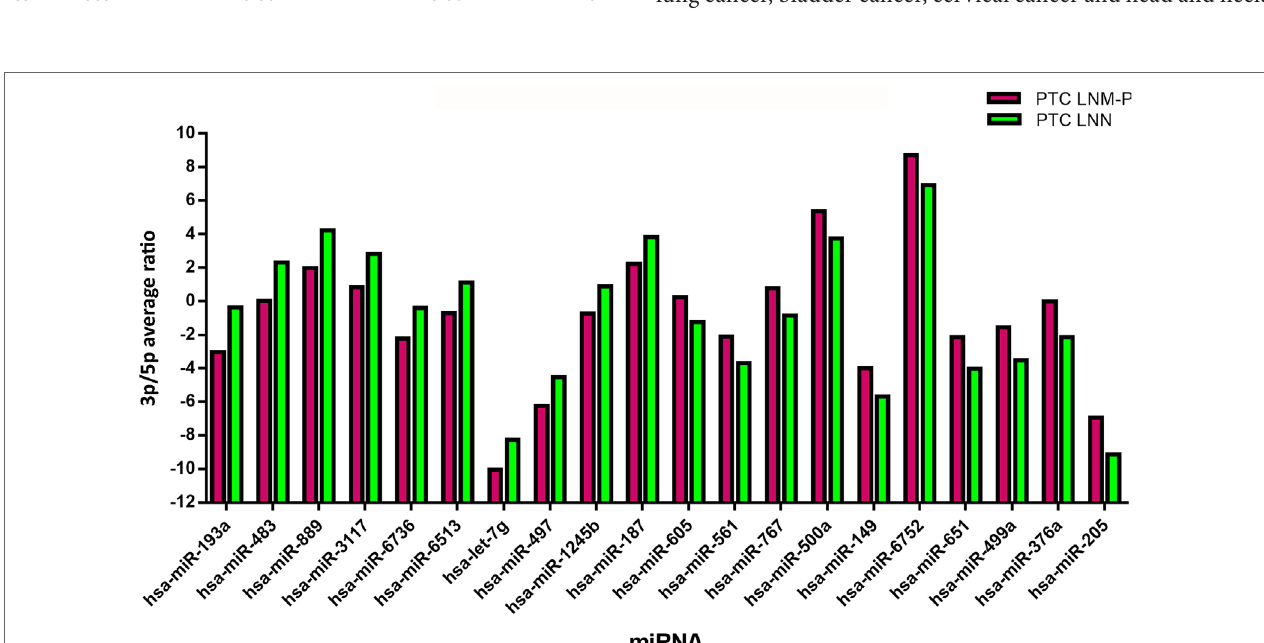
FigUre 5 | The top 20 3p/5p expression ratio in both comparison groups. Several microRNA (miRNA) have significant expression ratio shows that arm selection preference in miRNA are different significantly between papillary thyroid carcinoma (PTC) LNM-P and PTC LNN.